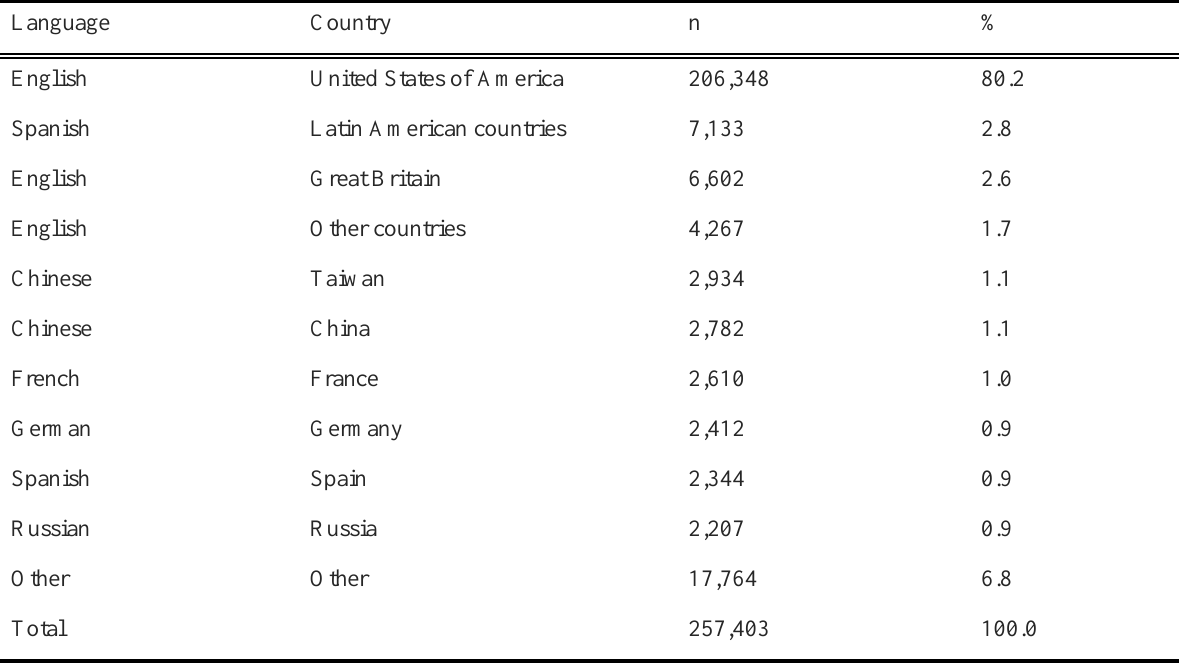
Table II: Languages of Lectures from the Supercourse Webpage